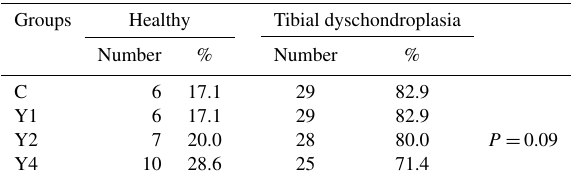
Table 4. Effects of Saccharomyces cerevisiae on tibial dyschon- droplasia in broiler chickens.